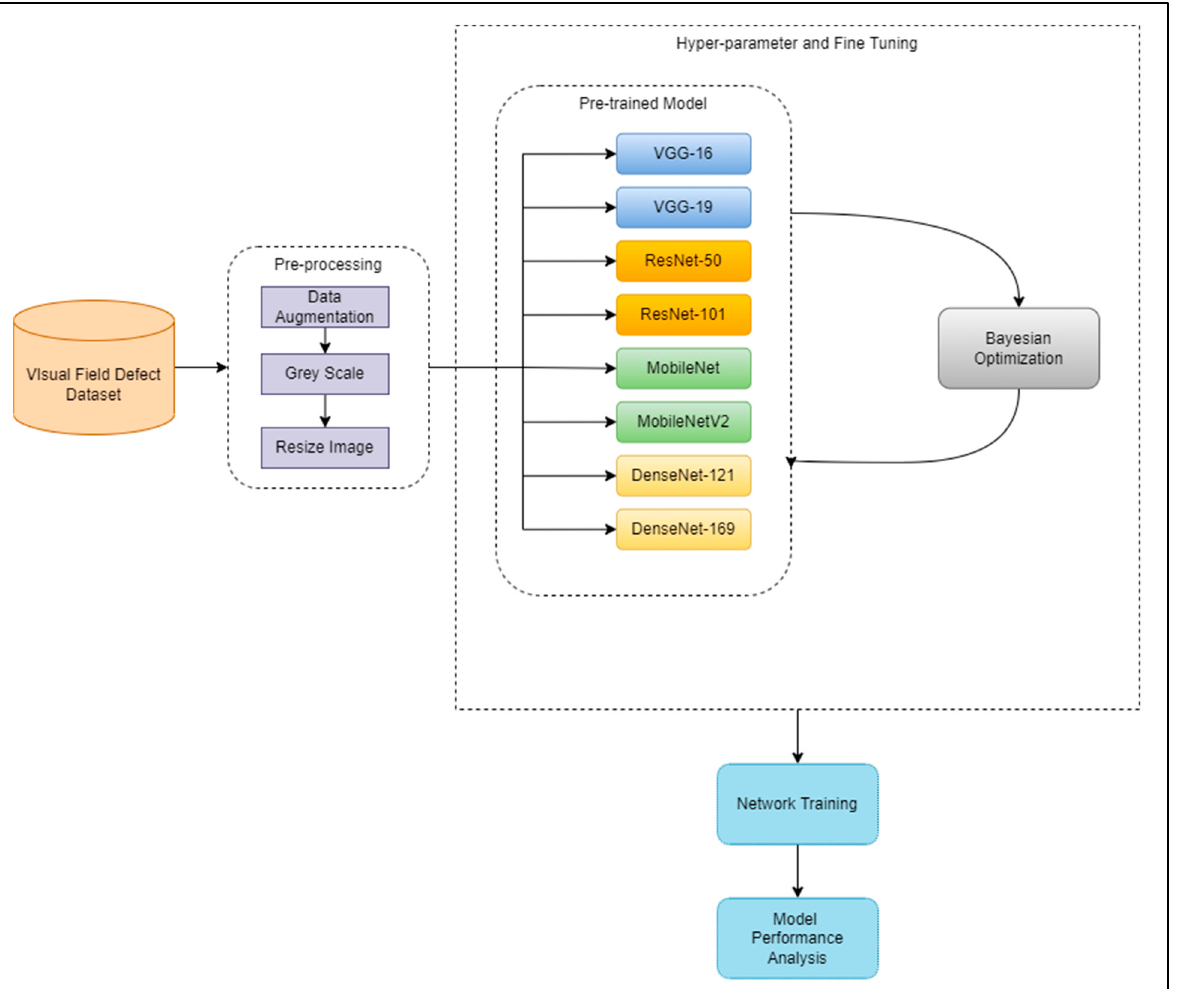
Figure 3. The framework of a comprehensive analysis of automated hyperparameters and automated fine-tuning for pre-trained models.